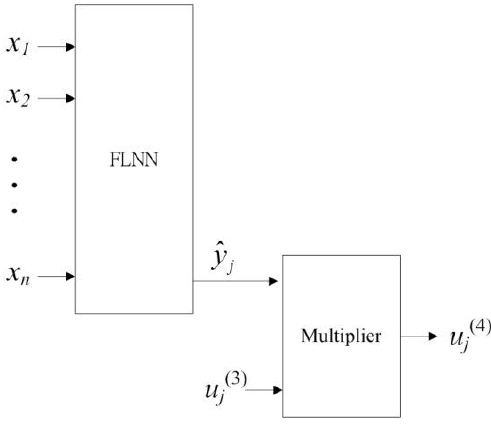
Figure 20. Consequence unit module.